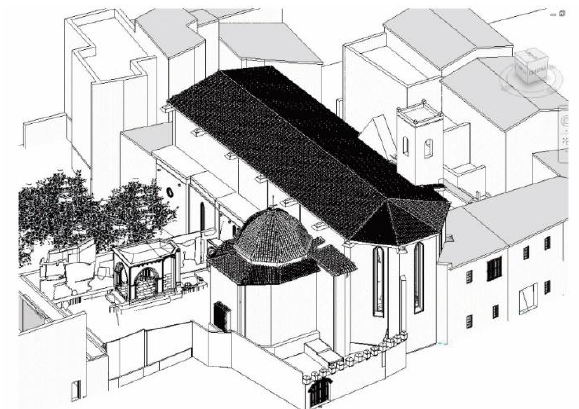
Figure 2. HBIM model of San Juan del Hospital in Valencia.